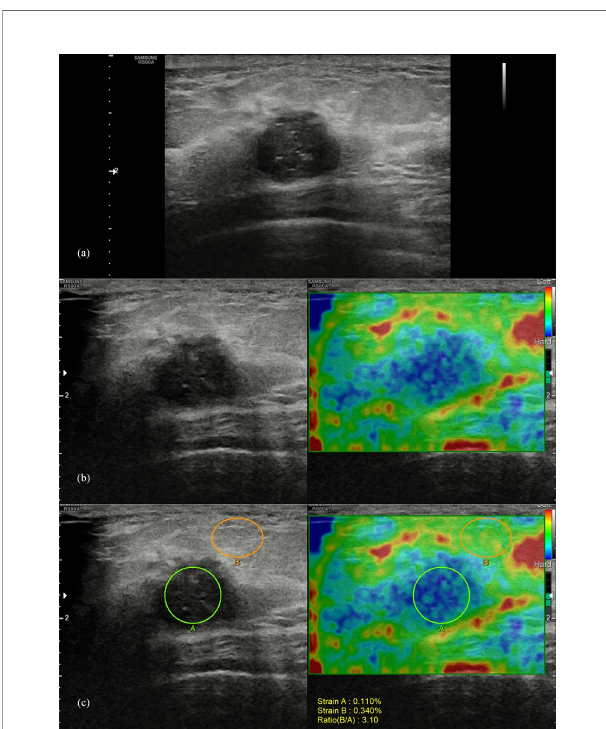
FIGURE 1 | Pathologically con fi rmed breast invasive ductal carcinoma in a 44-year-old female patient. Ultrasound images of the long-axis section of the breast mass were evaluated as BI-RADS 4c (A) , with an elasticity score of 4 (B) , and a strain ratio of 3.1 (C) .